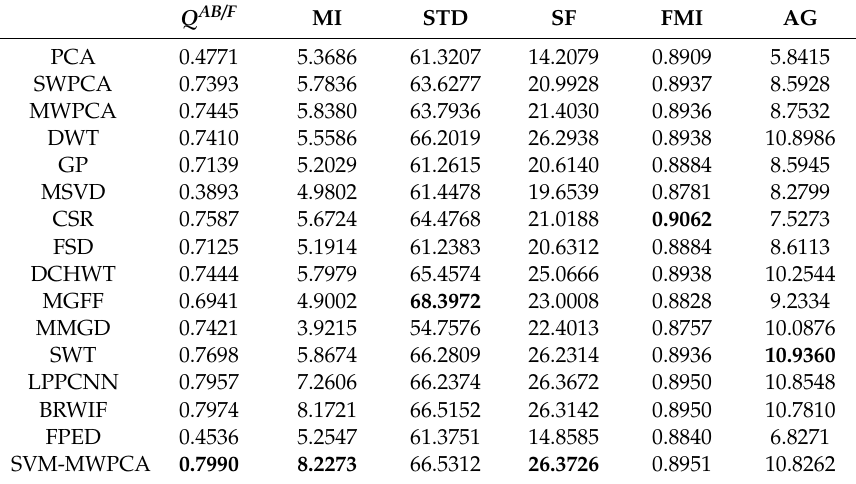
Table 5. Evaluation indexes of the fused images in source image pair “wine bottle”.